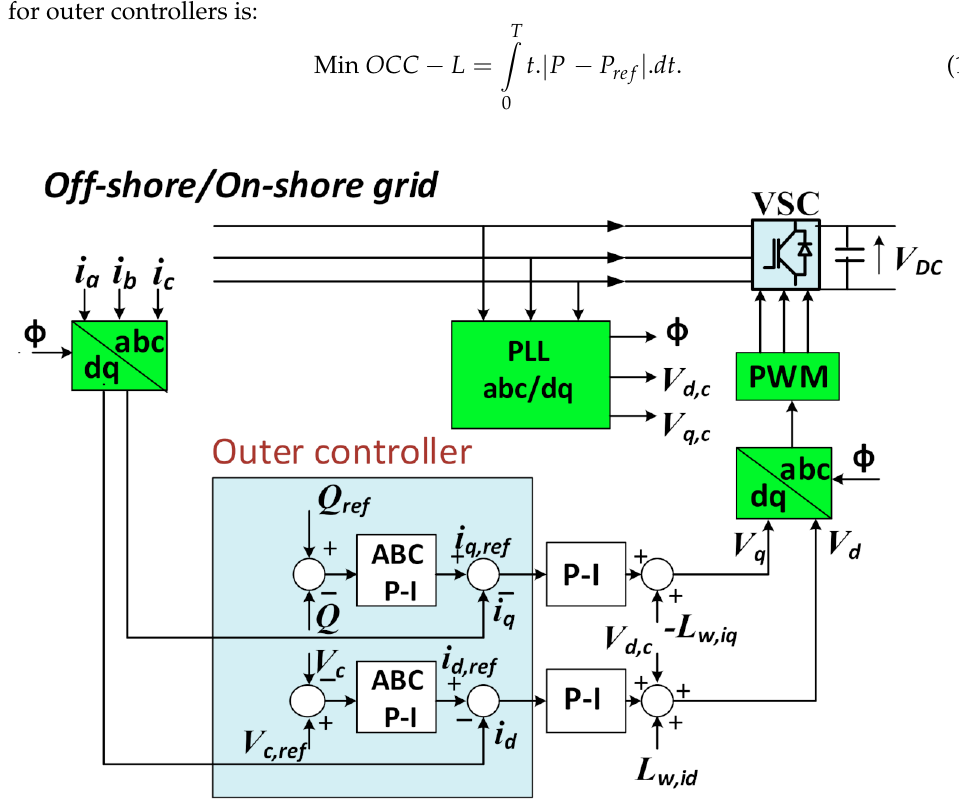
Figure 8. ABC-based control structure of Outer-Current Control Loop